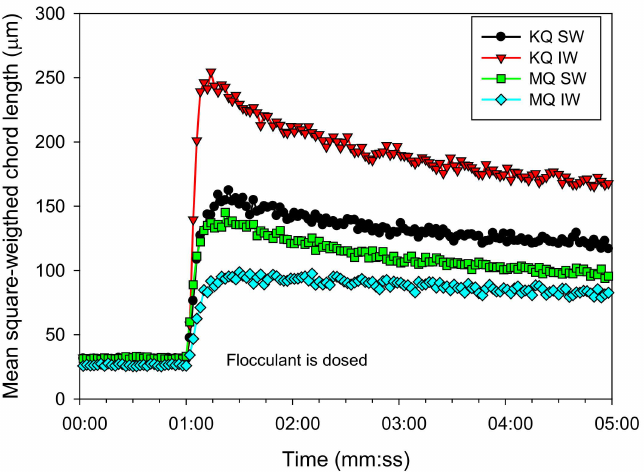
Figure 6. Flocculation kinetics of kaolin-quartz (KQ) and montmorillonite-quartz (MQ) tailings in SW and IW. Flocculant dose 34 g/t, mixing rate 180 rpm, solids concentration 8 wt% (clay/quartz 10/90), pH